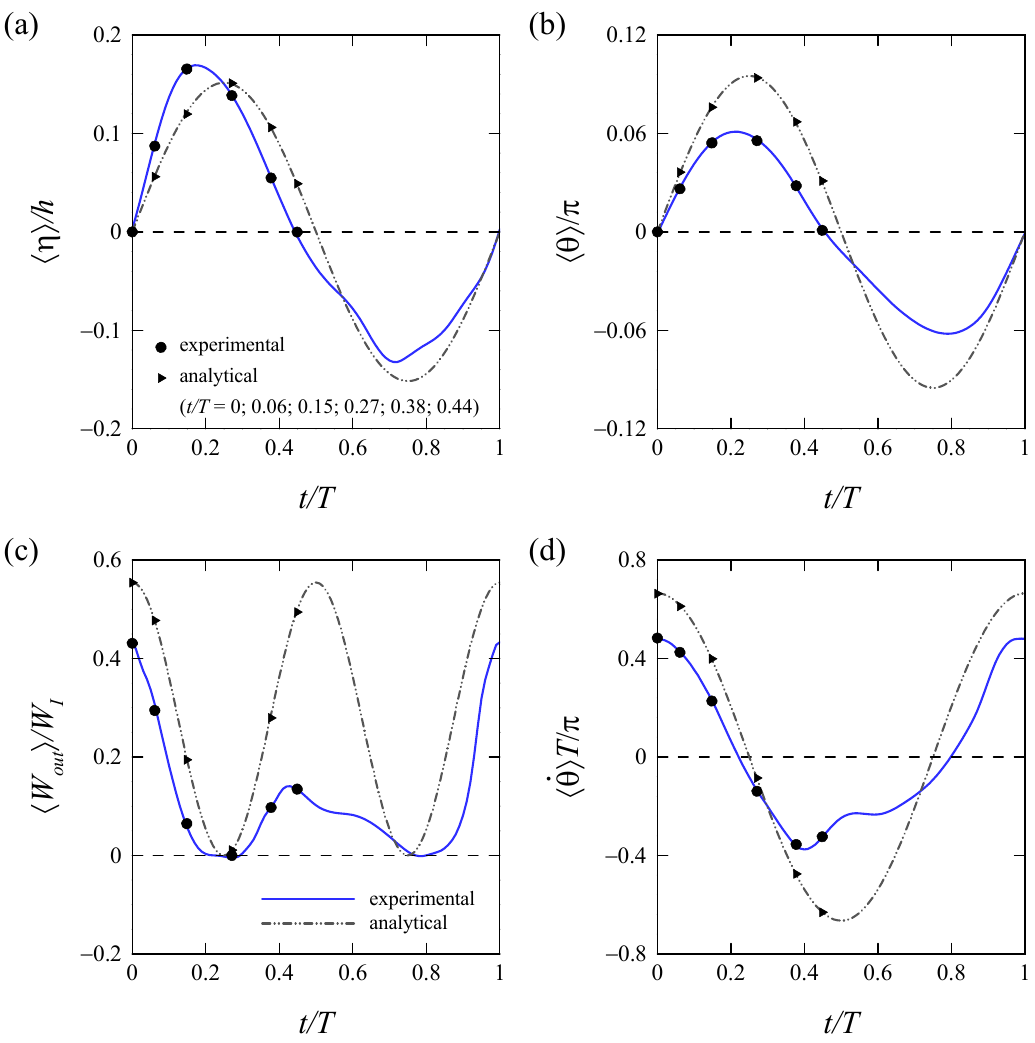
Figure 10. Comparison between experimental and analytical phase-averaged of normalized ( a ) free-surface elevation, ( b ) rotation, ( c ) power capture, and ( d ) angular velocity of the flap.